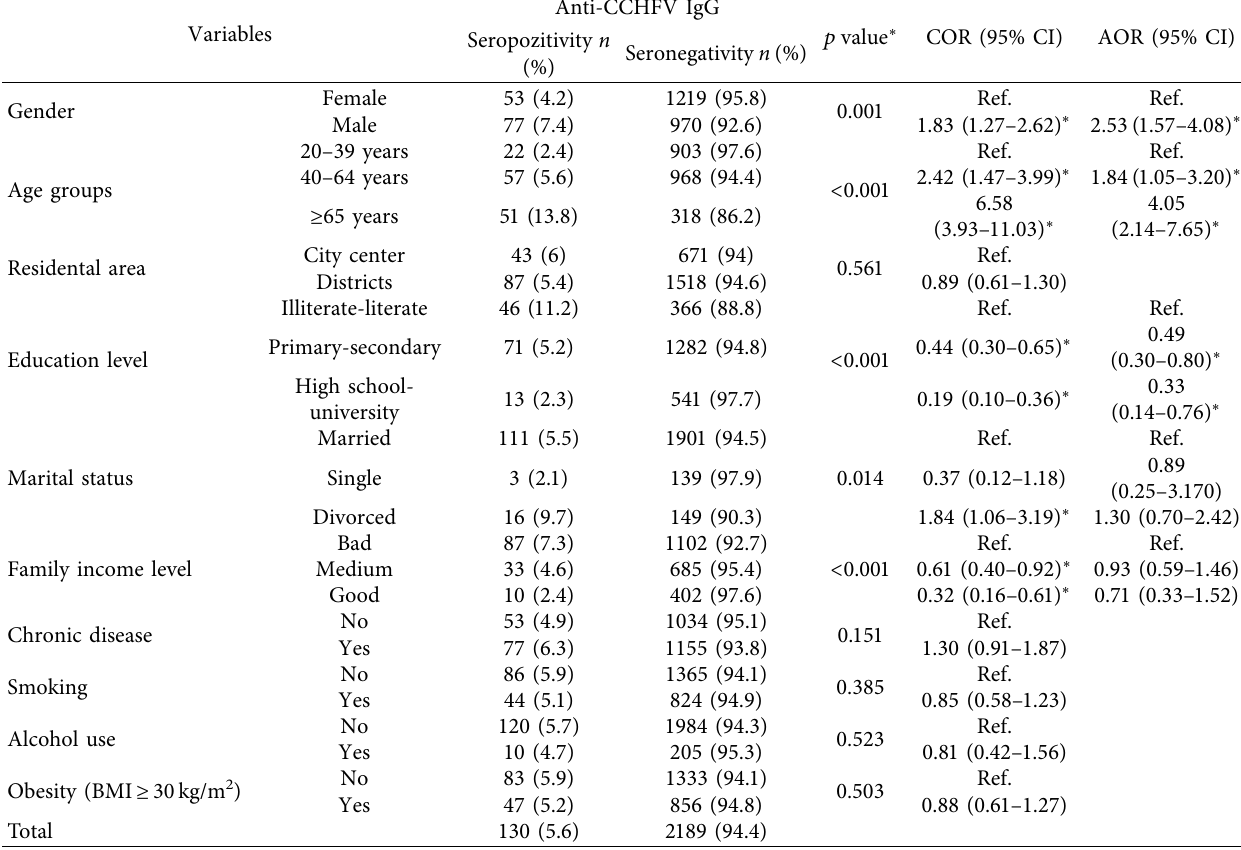
Table 4: Logistic regression analysis of the descriptive characteristics of the participants in terms of anti-CCHFV IgG seropositivity ( n �